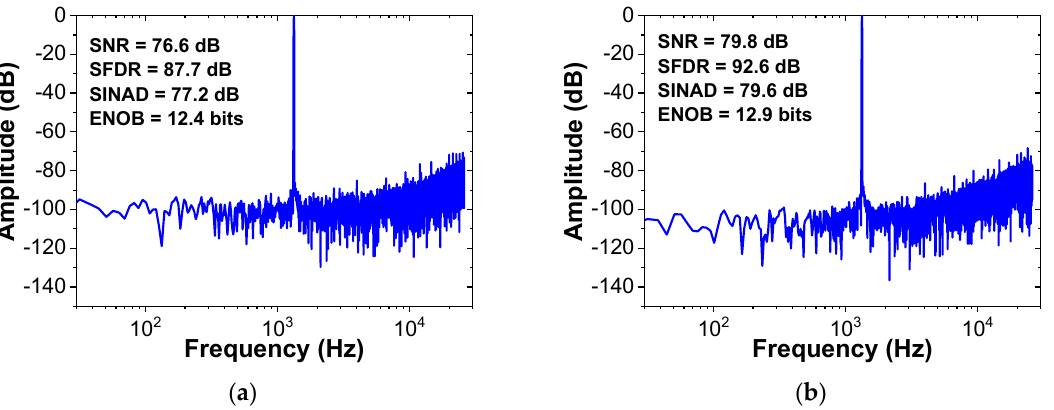
Figure 10. Output spectra of the ADC. ( a ) Previous work and ( b ) proposed work. f in = 1.33 kHz, OSR = 10.